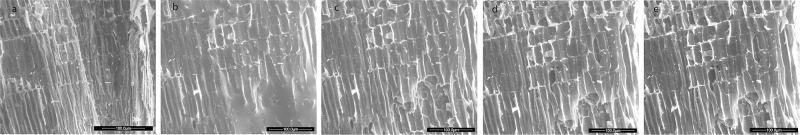
ESEM images of hydration and dehydration cycles performed on the hemp shives.(a) before hydration, at 3.5 torr corresponding to 70% of RH; (b) complete hydration, at 5.2 torr, corresponding to 100% of RH; (c) beginning of dehydration, at 4.6 torr, corresponding to 90% of RH; (d) dehydration at 4.1 torr, corresponding to 80% of RH; (e) end of dehydration, at 3.5 torr corresponding to 70% of RH. Observations were made at 2°C.